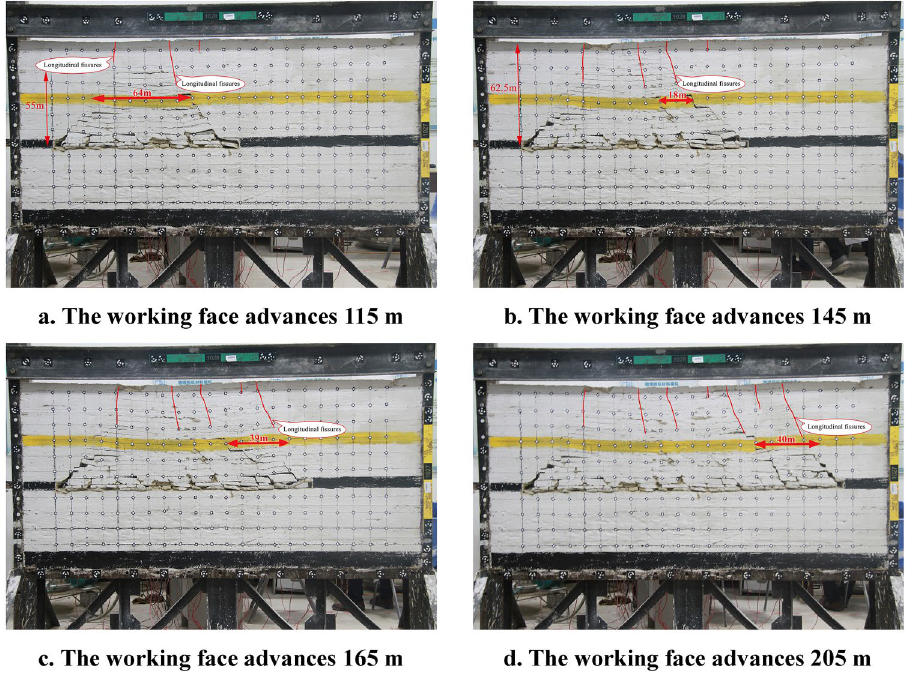
Figure 5. Overburden rock instability characteristics and fissures distribution characteristics of the key bearing layer located within the fissure zone.